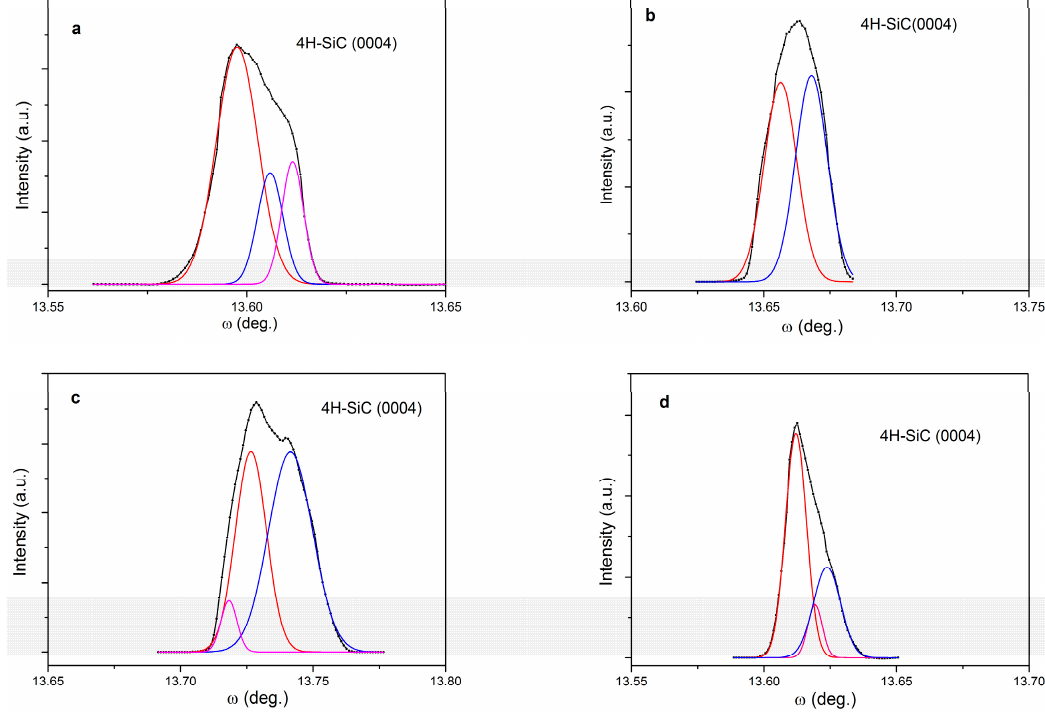
Figure 7. X-ray diffraction ( XRD) spectra of epitaxial layers grown at different pressures: ( a ) 100 mbar; ( b ) 80 mbar; ( c ) 60 mbar; ( d ) 40 mbar.